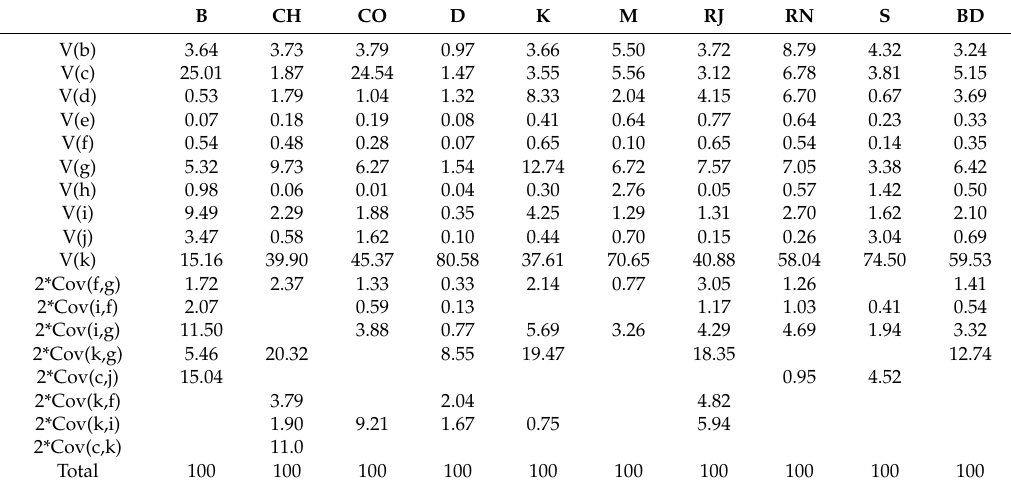
Table 9. Decomposed variances share (%) of costs for aman HYV rice production, by region. B CH CO D K